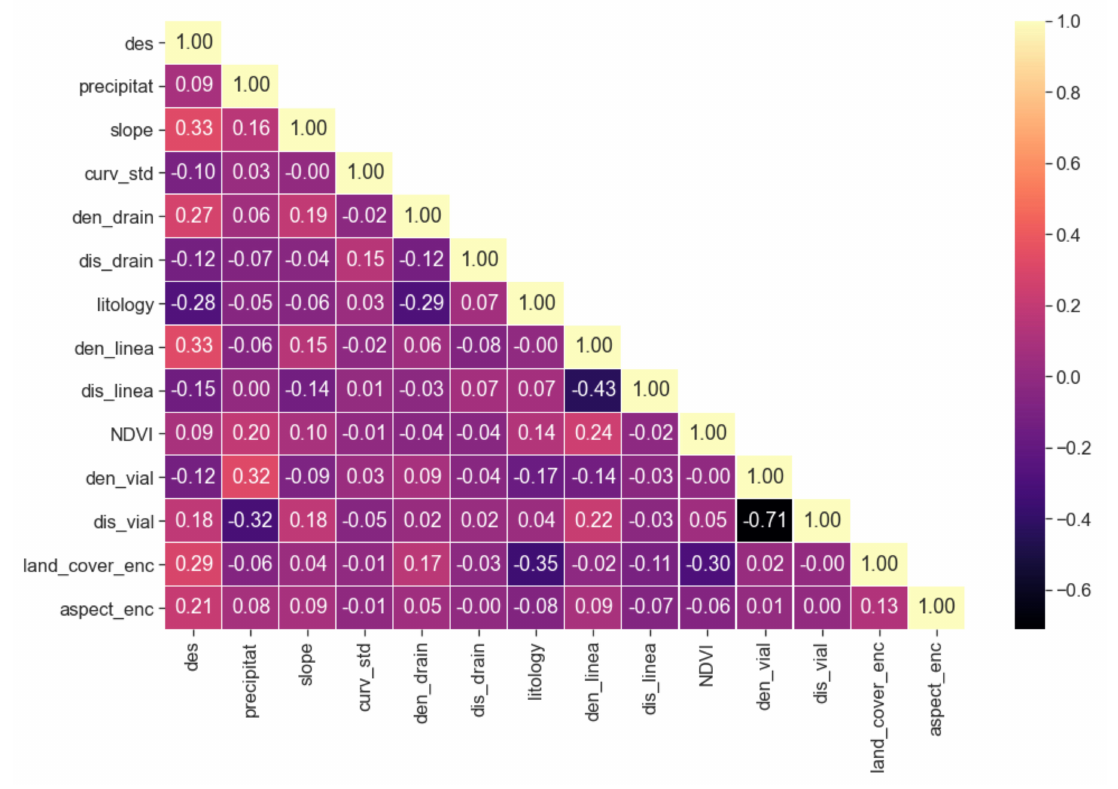
Figure 4. Pearson’s correlation plot includes explanatory variables and the variable to be explained.